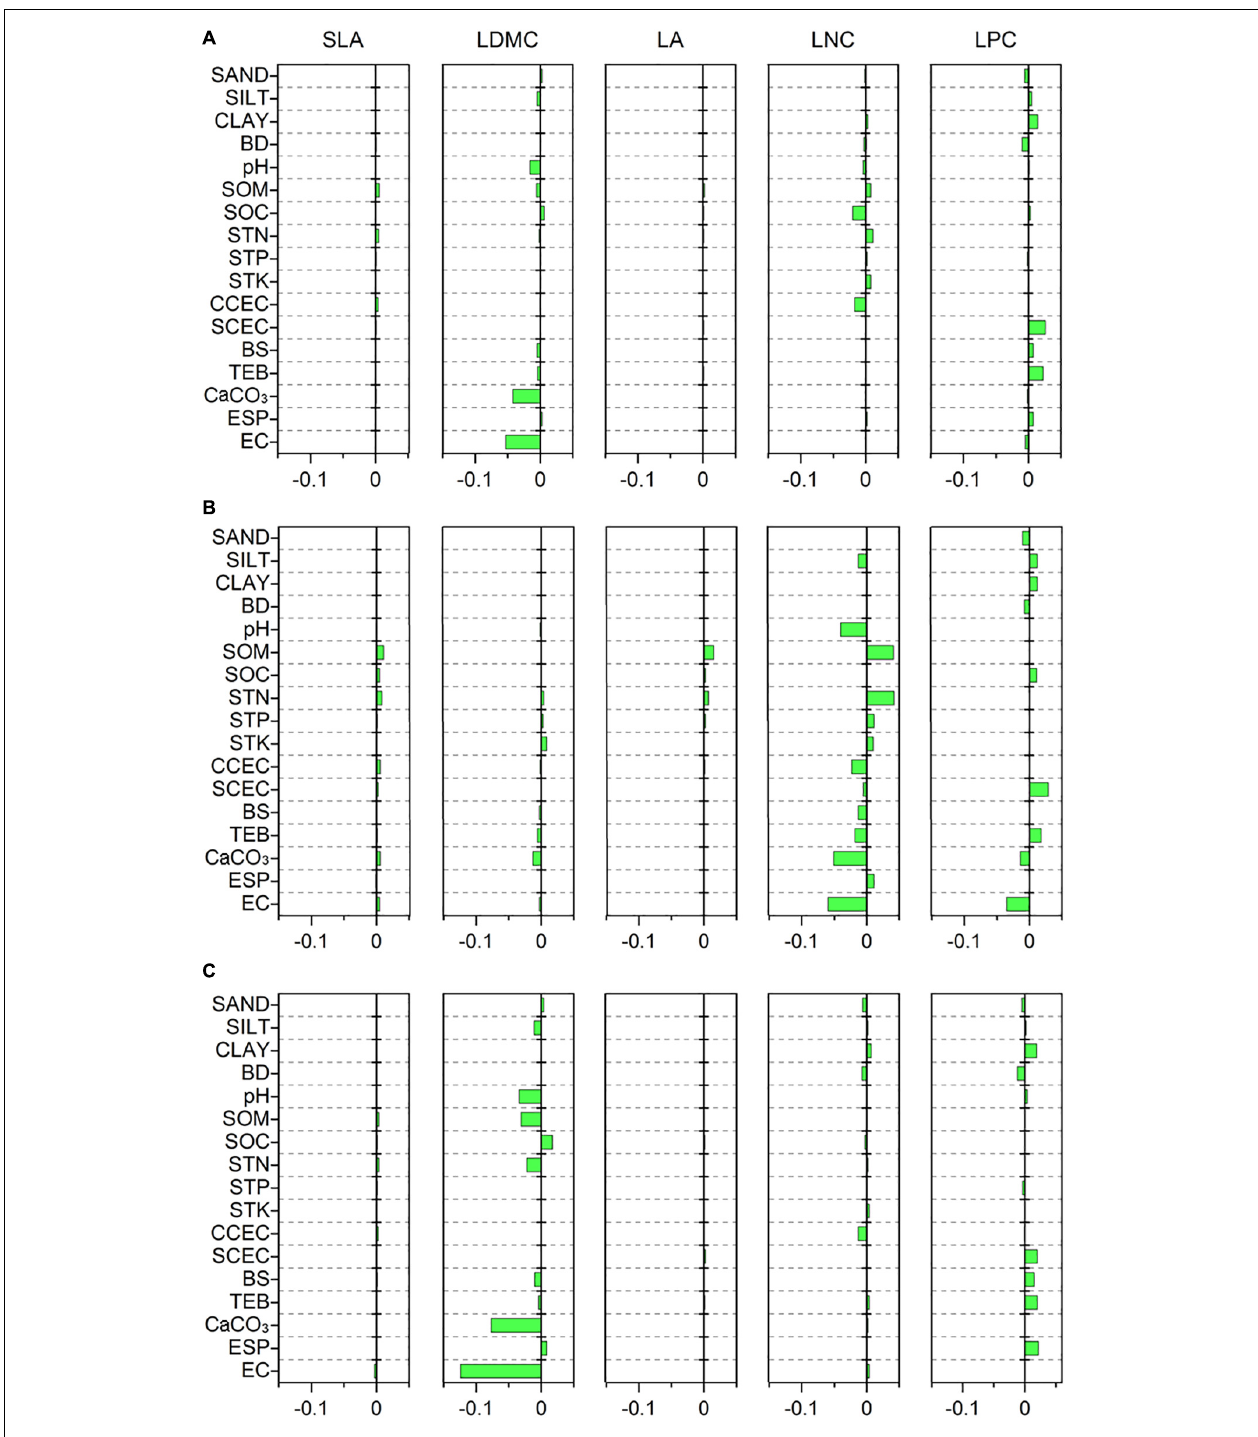
FIGURE 4 | Correlations of leaf traits with soil variables based on a phylogenetic linear mixed model (PLMM). Significant correlations between leaf traits and soil variables are shown ( p < 0.05). Positive values represent positive correlations between leaf traits and soil variables, while negative values represent negative correlations between them. (A) All species; (B) herbaceous species; (C) woody species. SLA, specific leaf area; LDMC, leaf dry matter content; LA, leaf area; LNC, leaf N concentration; LPC, leaf P concentration; SAND, percentage of sand fraction; SILT, percentage of silt fraction; CLAY, percentage of clay fraction; BD, bulk density; SOM, soil organic matter; SOC, soil organic carbon; STN, soil total N; STP, soil total P; STK, soil total K; CCEC, clay cation exchange capacity; SCEC, soil cation exchange capacity; BS, base saturation; TEB, total exchangeable bases; CaCO 3 , calcium carbonate content; ESP, exchangeable sodium percentage; EC, electrical